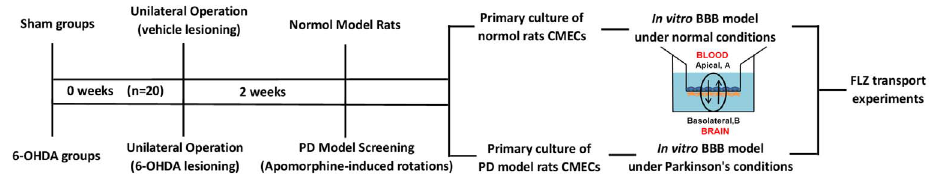
Figure 2. Experimental design. Rats were randomly divided into sham and 6-hydroxydopamine (6-OHDA) groups (n=20 per group) which were injected with vehicle or 6-OHDA (10 m g) unilaterally into the SN, respectively. The successfully PD model rats were screened by apomorphine (0.5 mg/ kg) two weeks later after unilateral operation. Then primary normal and PD rCMECs were isolated from brain microvessel fragments of sham and PD model rats and contact co-culture with C6 astroglial cells to construct physiological and PD pathological in vitro BBB models, respectively. The transport of FLZ was measured on the physiological and pathological in vitro BBB models in the absence or presence of transporters specific